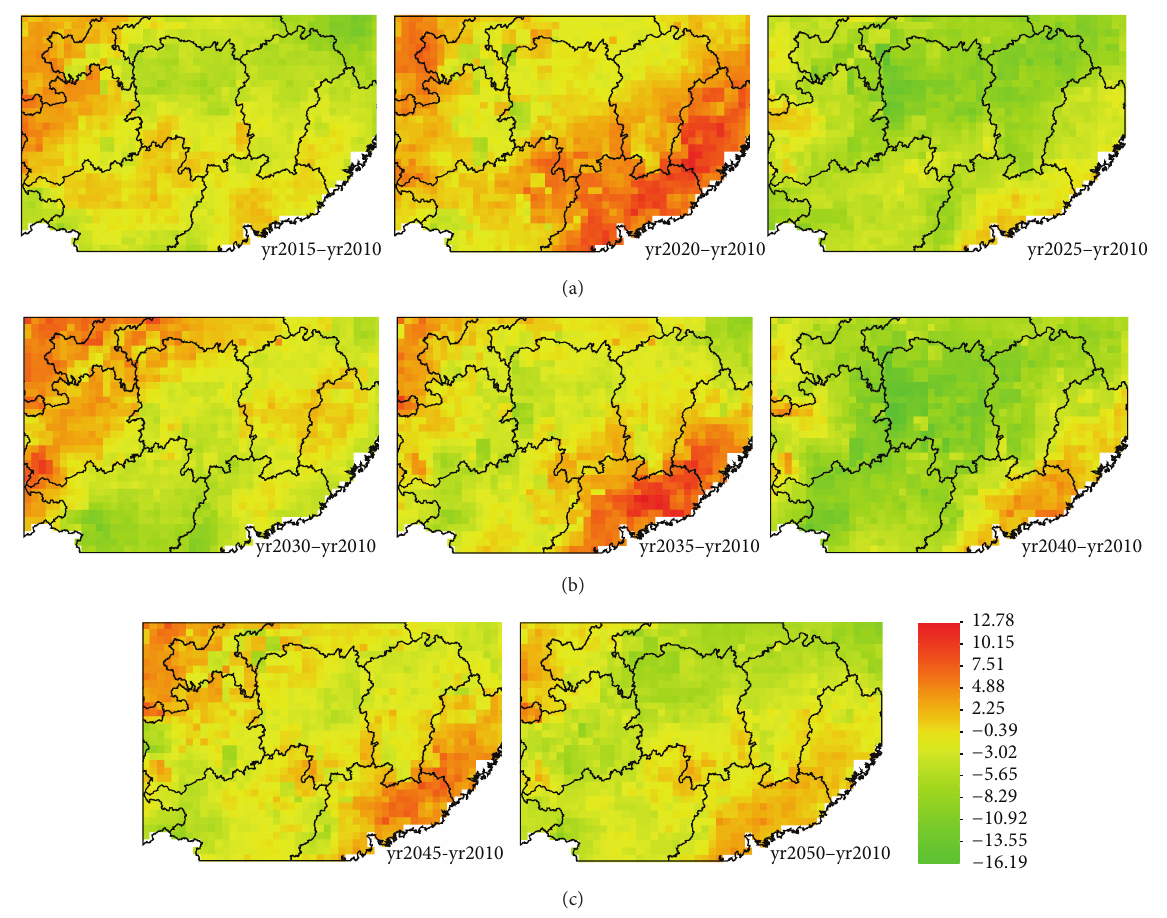
Figure 5: Interannual spatial dynamic of H (Wm −2 ) in the next 40 years under A2a